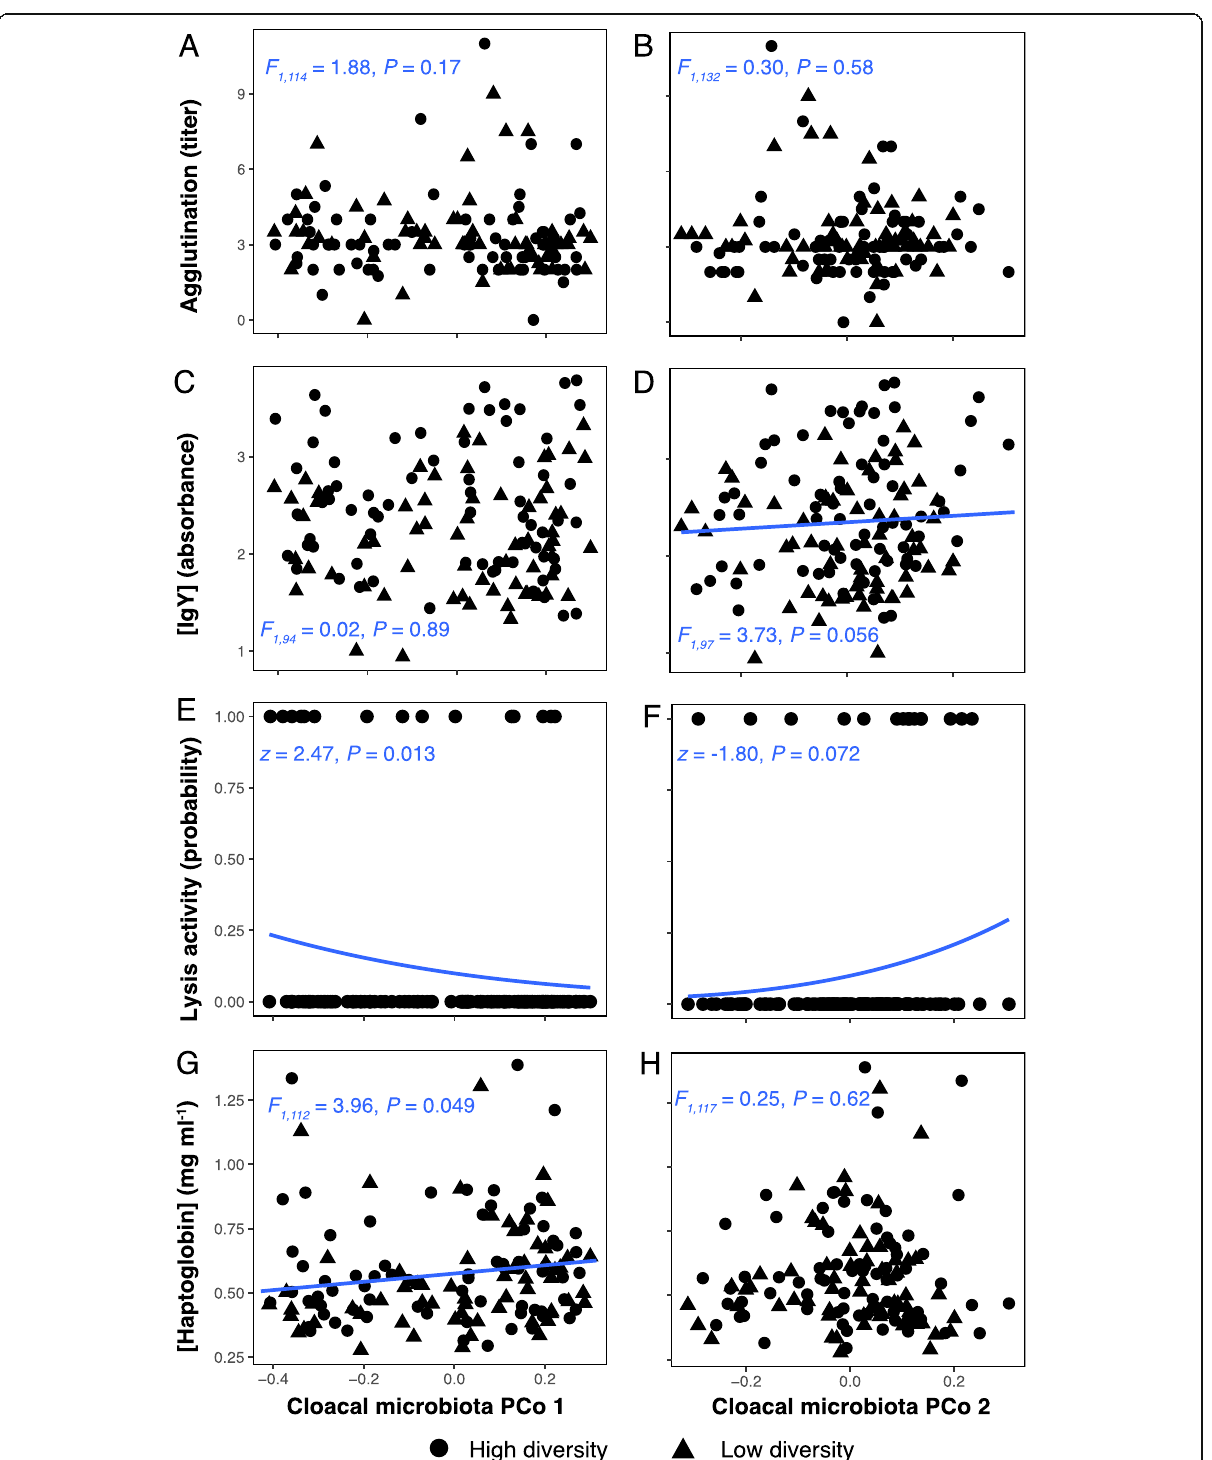
Fig. 5 Relationships between individual immune indices and cloacal microbiota PCoA scores. Model predictions (mean=blue line) for ( a , b ) Agglutination titer, ( c , d ) IgY concentration, ( e , f ) Lytic activity and ( g , h ) haptoglobin along the first (PCo 1) and second (PCo 2) axis of unweighted UniFrac, respectively. Black dots are individual plasma samples. g LMM statistics are shown in each